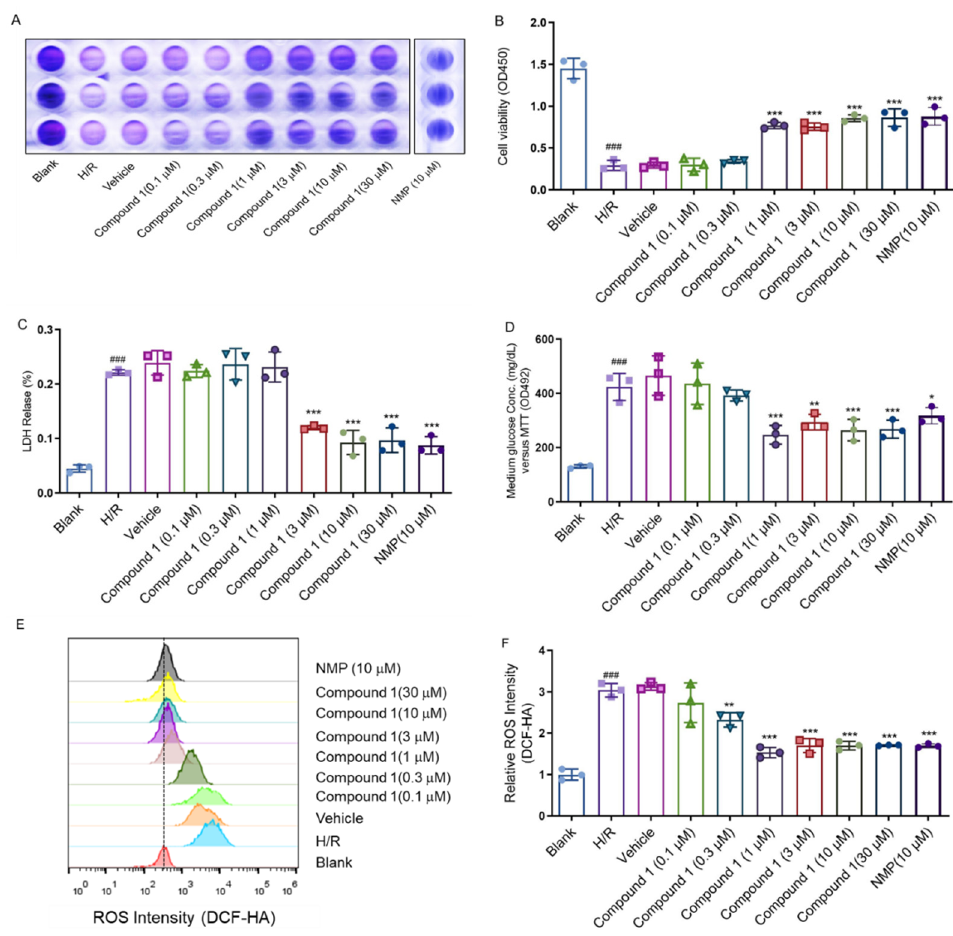
Figure 3. ( A,B ): Cell viability ( C ): LDH Release. ( D ): Medium glucose content: ( E , F ): Relative ROS intensity. Data represent mean ± SD (* p < 0.05, ** p < 0.01, *** p < 0.001, vs. H/R Group; ### p < 0.001, vs. Blank Group).